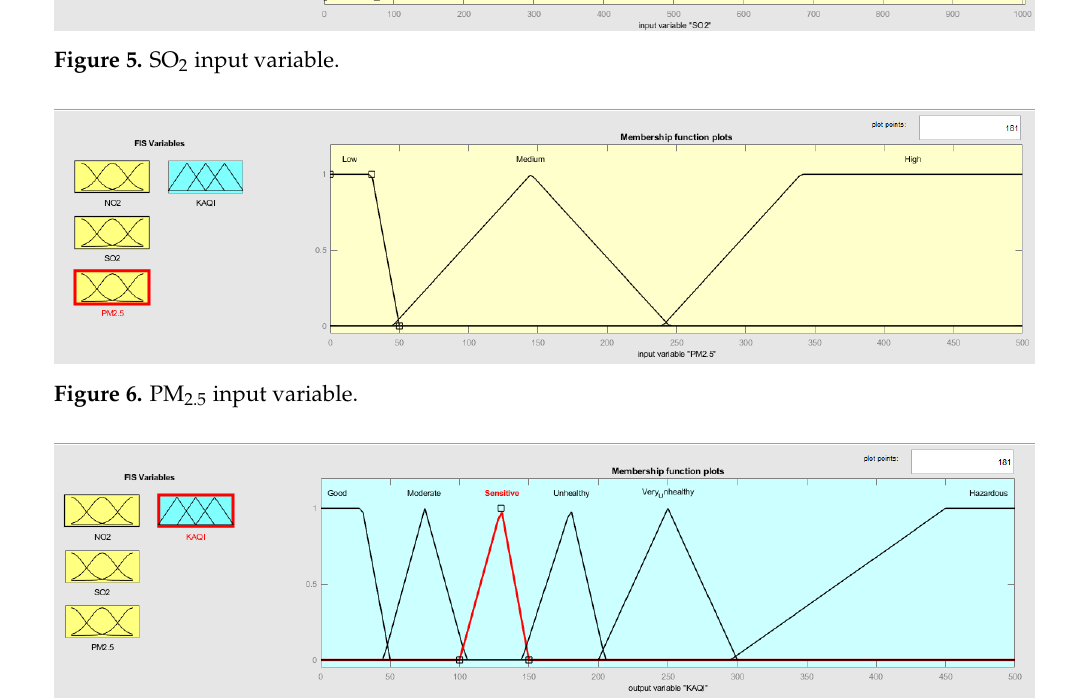
Figure 7. KAQI output